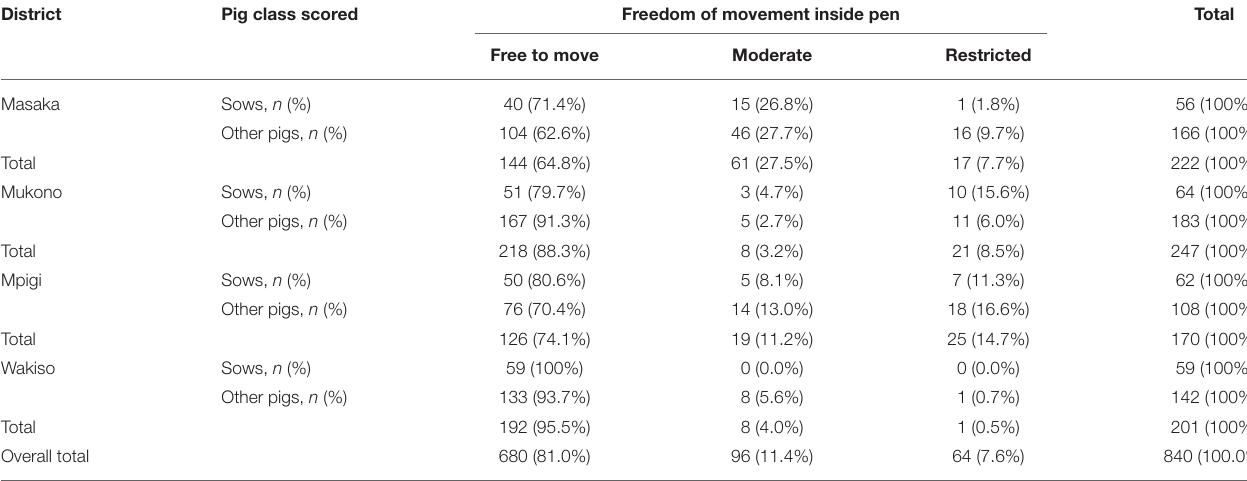
TABLE 10 | Summary of proportions of different categories of pigs by freedom of movement level.